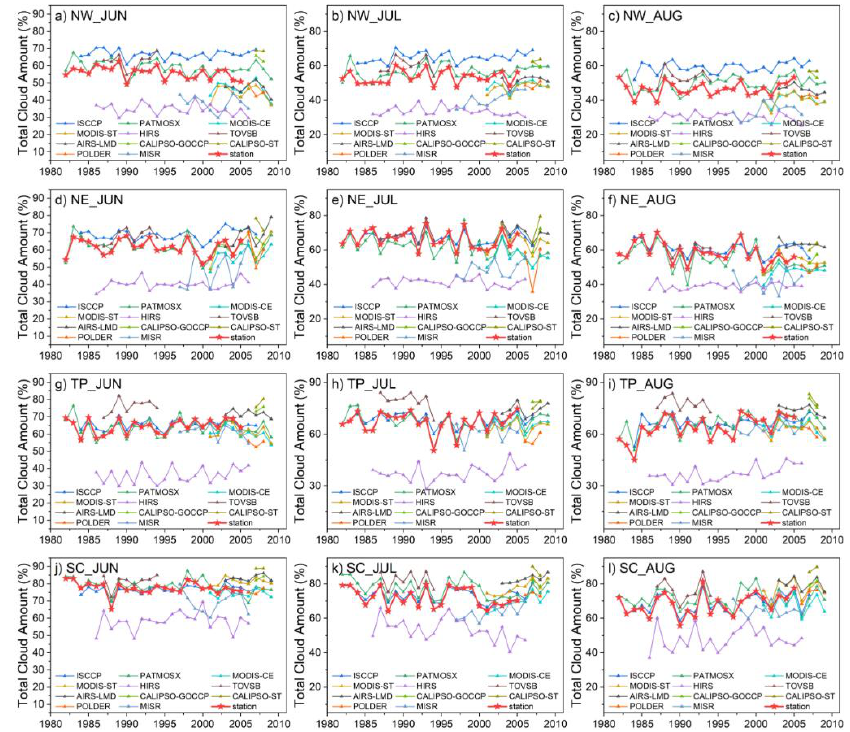
Figure 10. Temporal variations of TCA averaged over four regions of China in June, July, and August. ( a , b ) NW region; ( c , d ) NE region; ( e , f ) TP region; and ( g , h ) SC region. The red pentagram (red lines) represents site observations, and the other colored symbols represent results from different satellite da- tasets.